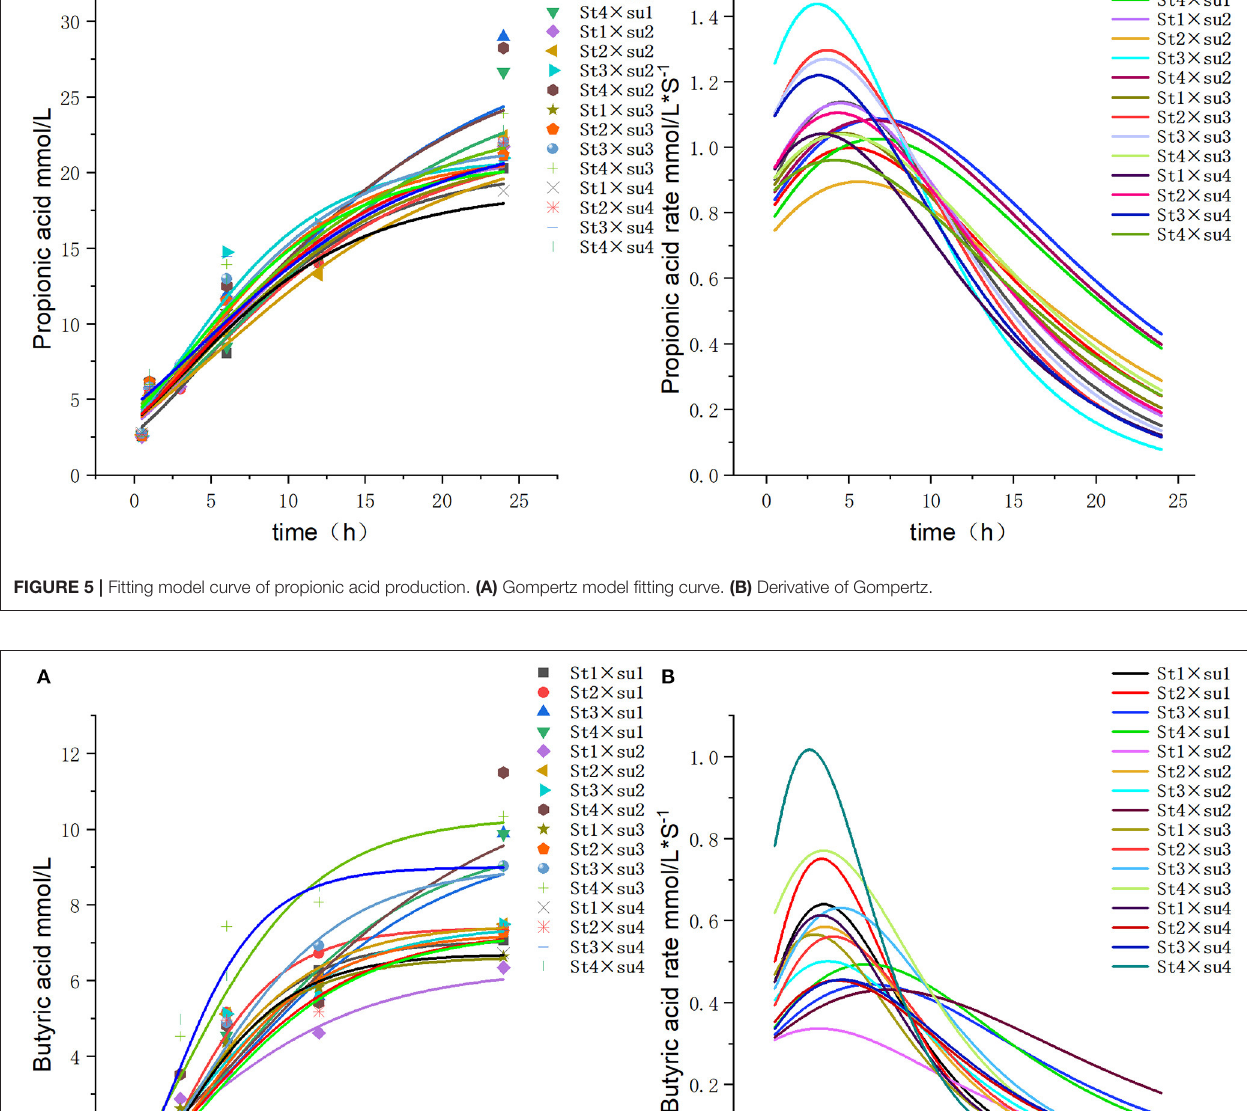
of unidentified_[Paraprevotellaceae] , unidentified_S24-7 , and Pseudobutyrivibrio was higher in the Hh group than in the Ll group ( P < 0.05), while that of Acinetobacter was significantly lower in Hh group than in the Ll group ( P <